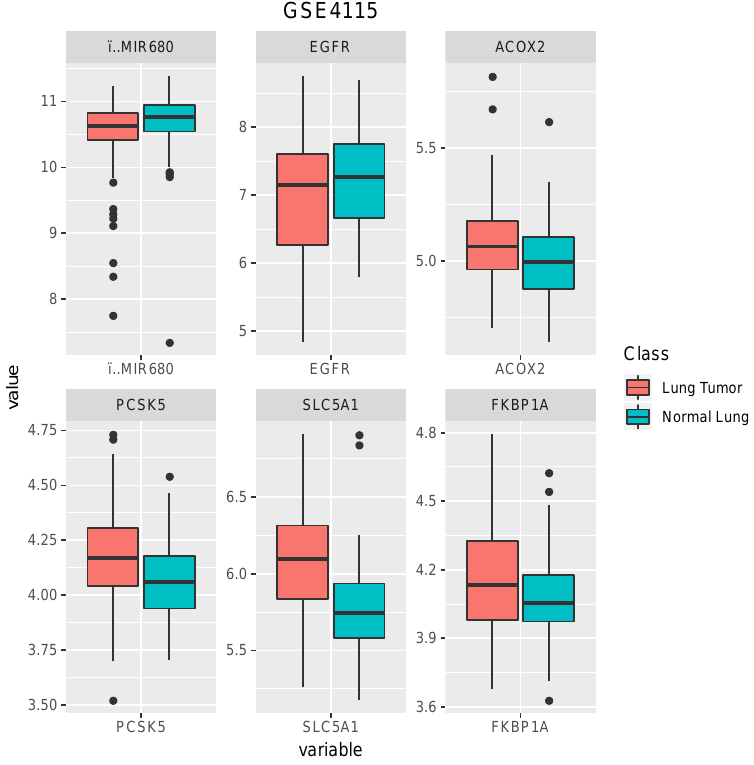
Figure 5. The box plots of selected genes by L 1/2 for dataset